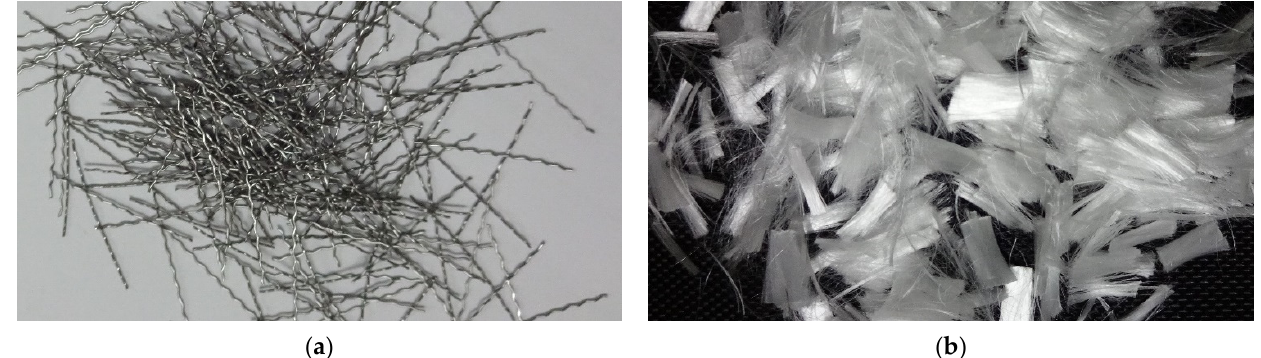
Figure 1. Fibres used: ( a ) crimped steel fibres; ( b ) polypropylene fibres.